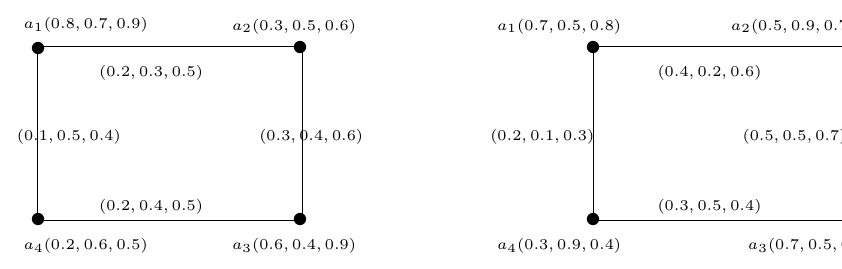
( e ) , (cid:101) H ( e ) } P,V 1 P,V 2